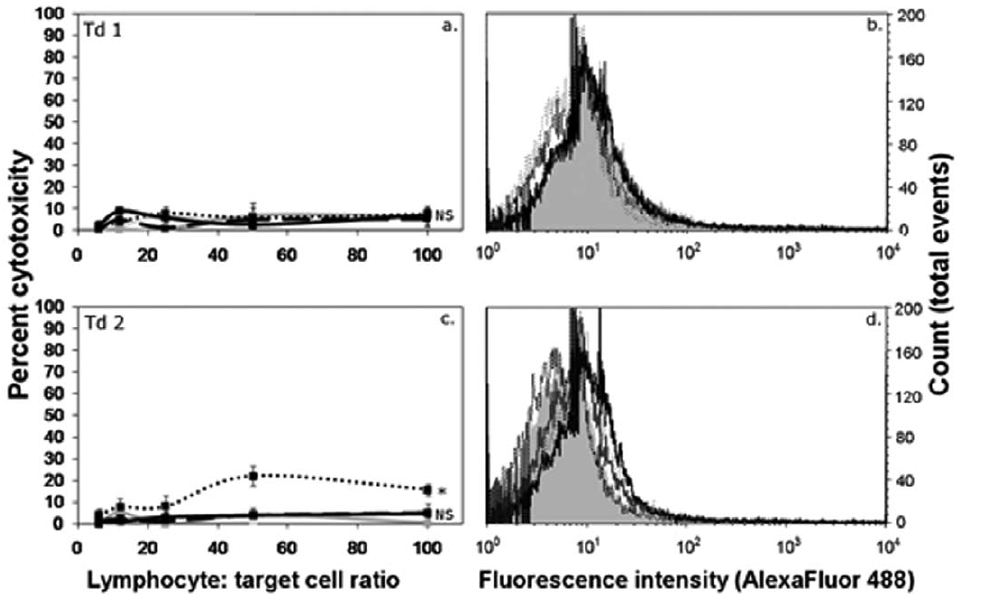
Figure 1. Cytotoxic and antibody responses against DFTD tumour cells. 51 Cr release assays were performed for 18 hr at lymphocyte: target ratios of 100:1, 50:1. 25:1. 12:1, 6:1 and 3:1 (panels a and c). Pale grey lines represent pre-immune cytotoxicity levels. Responses after a single dose are shown as dark grey lines. Solid, dashed and dotted black lines represent the responses after two, three and four doses, respectively. One devil showed a weak increase in cytotoxicity after four doses, which was statistically significant compared to pre immune levels (F test; * p , 0.05). Flow cytometry was performed to detect antibodies in devil serum (panels b and d). Neither devil produced antibodies against DFTD.